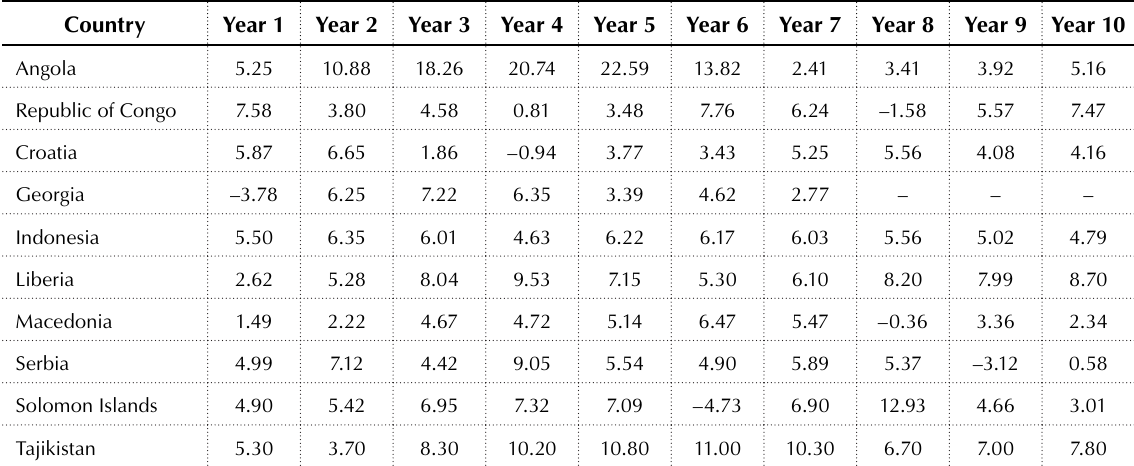
Source: World bank Open Data.